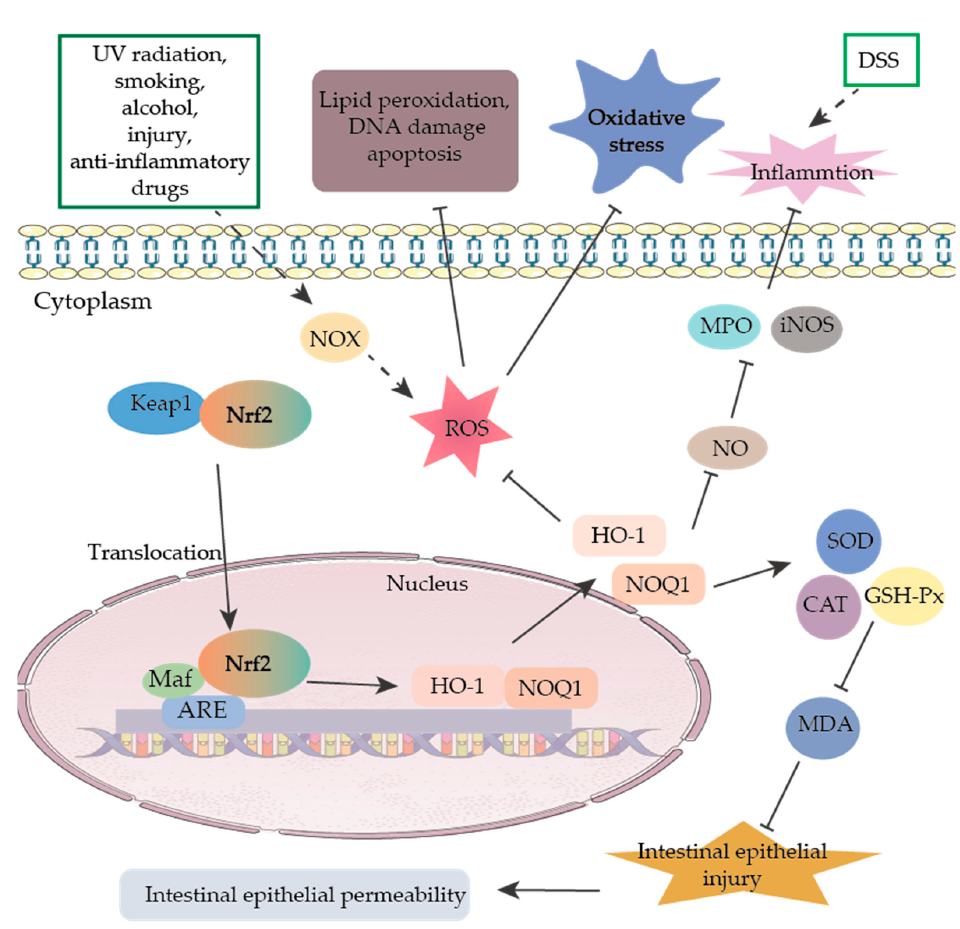
Figure 2. Regulation of oxidative stress through Nrf2 signaling pathway.